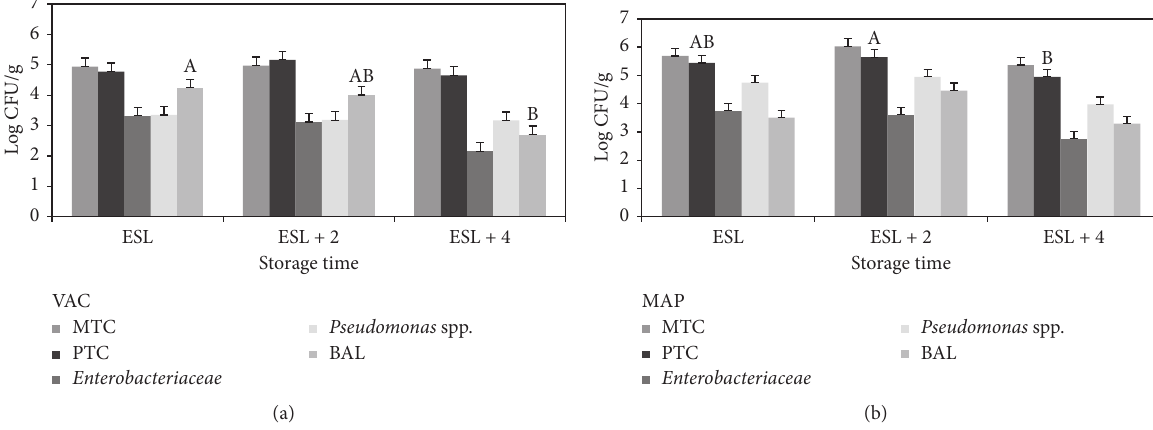
Figure 1: Counting of total mesophilic (MTM) and psychotropic (MTP) microorganisms, Enterobacteriaceae , Pseudomonas spp., and BAL in vacuum and map packed pork liver. Results expressed as mean values and CI (95%). Bars followed by different letters are different ( p < 0 . 05); bars without letters are similar ( p > 0 . 05). (a) VAC. (b)